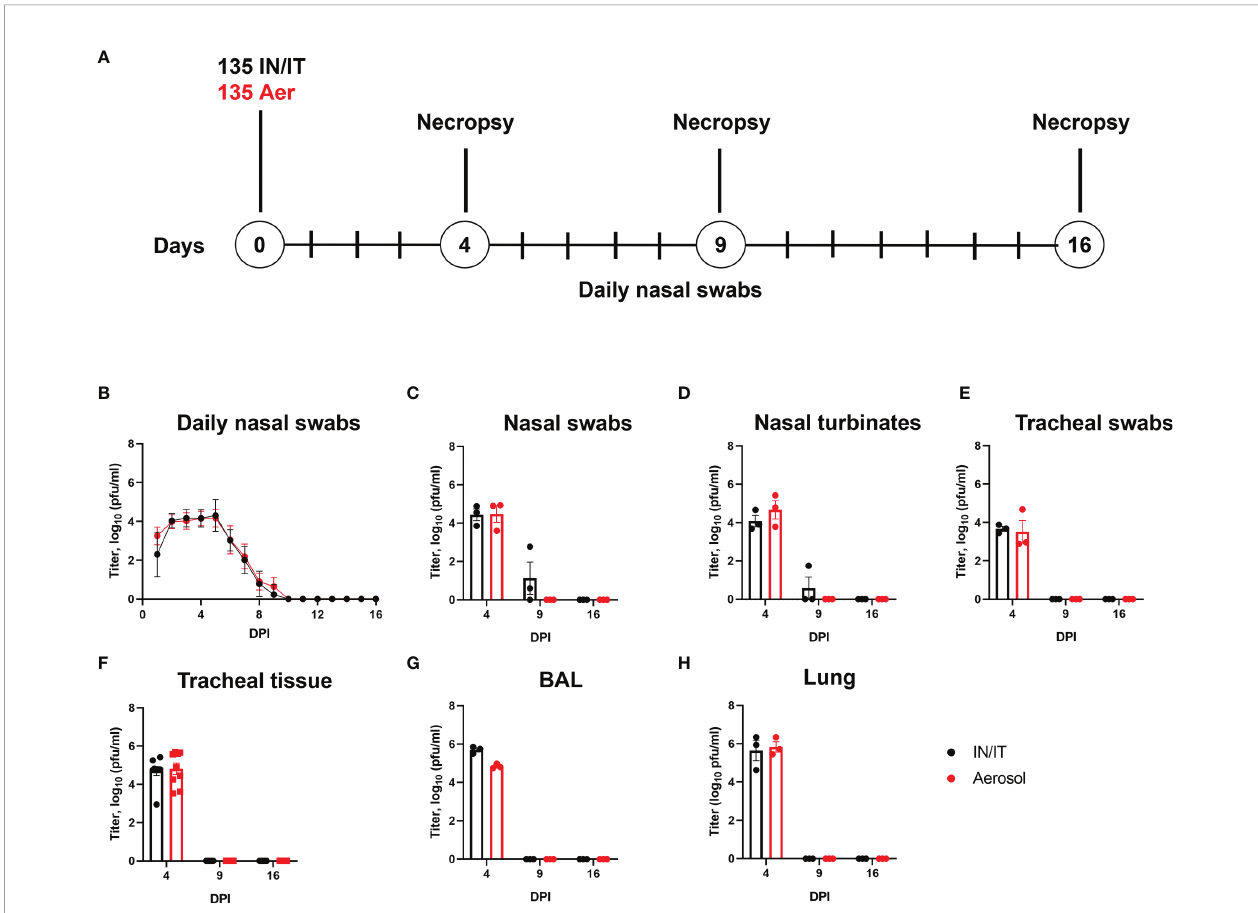
FIGURE 4 | Experimental design and virus load after in vivo challenge with PRCV 135. Eighteen pigs were infected with 1 x10 7 PFU of PRCV 135 by the intratracheal/intranasal route (IN/IT) or by aerosol (Aer). At 4-, 9- and 16-days post infection (DPI) three animals per group were culled (A) . Virus load in daily nasal swabs was determined by plaque assays; each point represents the mean titer with error bars indicating SEM (B) . At post-mortem nasal swabs (C), nasal turbinates (D) , tracheal swab (E) , tracheal tissue (F) , BAL fl uid (G) and lung accessory lobe (H) were harvested, and virus load determined. Each point represents one animal with errors bar de fi ning SEM. Statistical differences at each time point were analysed using a two-way ANOVA with a Tukey test for multiple comparisons; no differences between the groups were identi fi